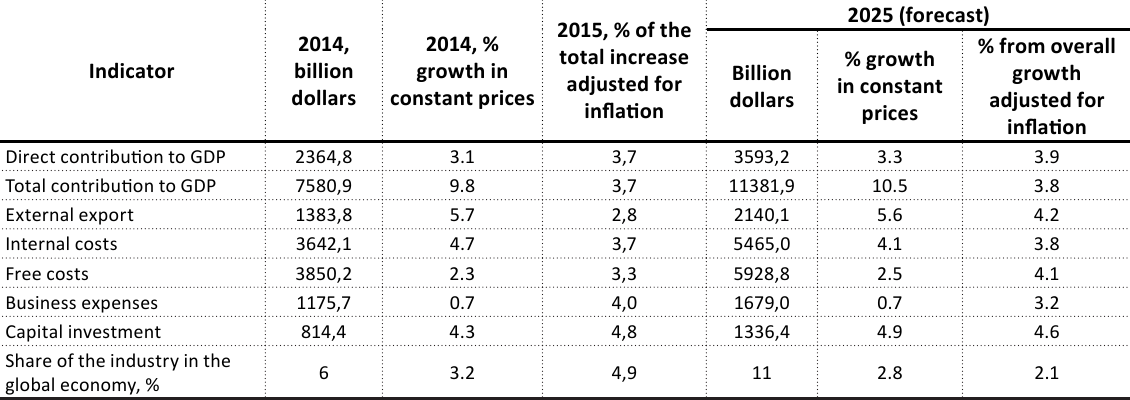
Table 1. Macroeconomic indicators of the international tourism market Source: Compiled and calculated based on World Travel & Tourism Council